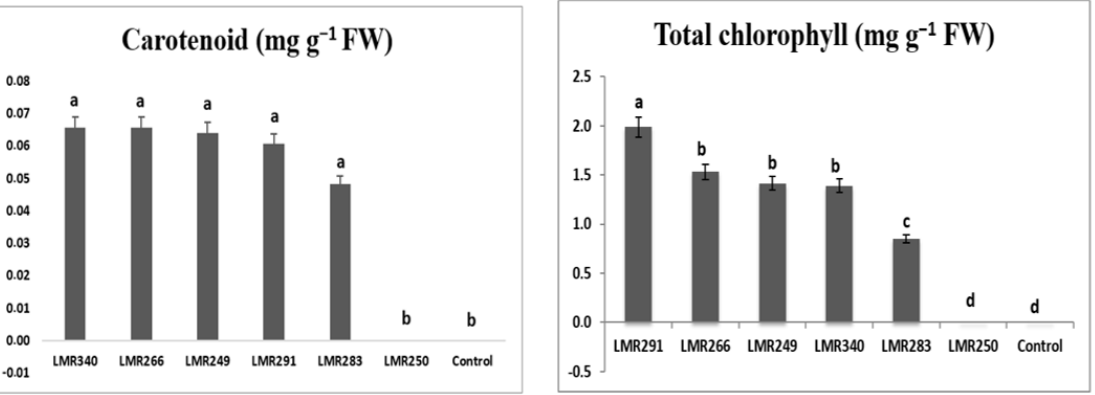
Figure 6. Total chlorophyll (mg g − 1 FW) and carotenoids (mg g − 1 FW) contents of Sulla plants growing in contaminated soils. Results are expressed as means ± SE ( n = 3). One-way ANOVA was performed for each factor. Means with different letters are significantly different from each other ( p < 0.05) according to the Duncan